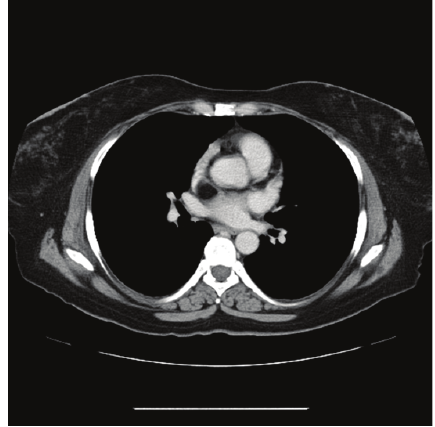
Figure 2: A second axial image, more cephalad, shows the septal lipoma, compressing the superior vena cava.